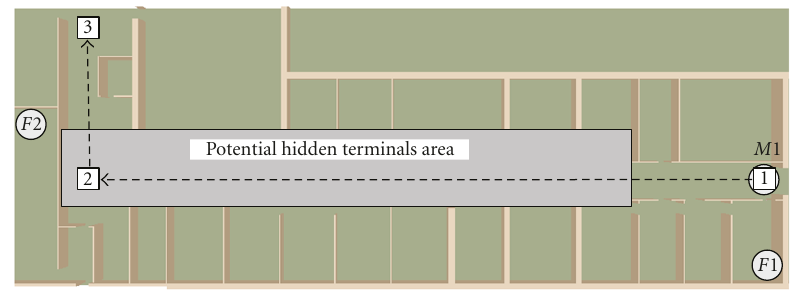
Figure 16: Example of hidden terminal experiment.